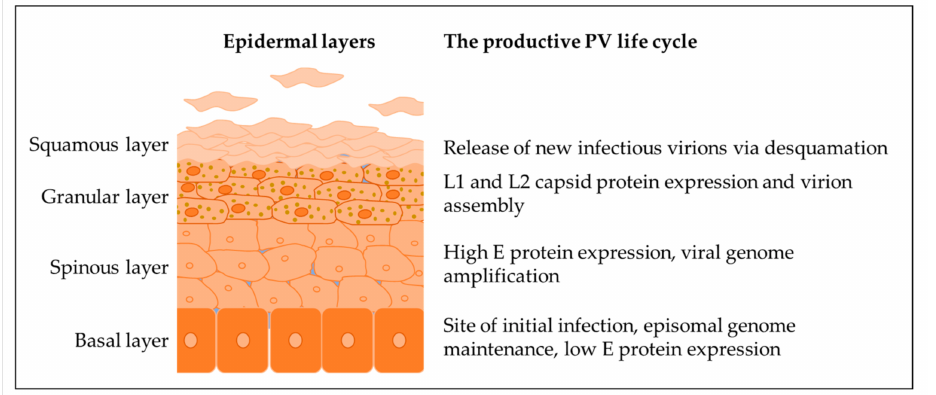
Figure 1. The productive PV life cycle is tightly linked to the differentiation program of infected